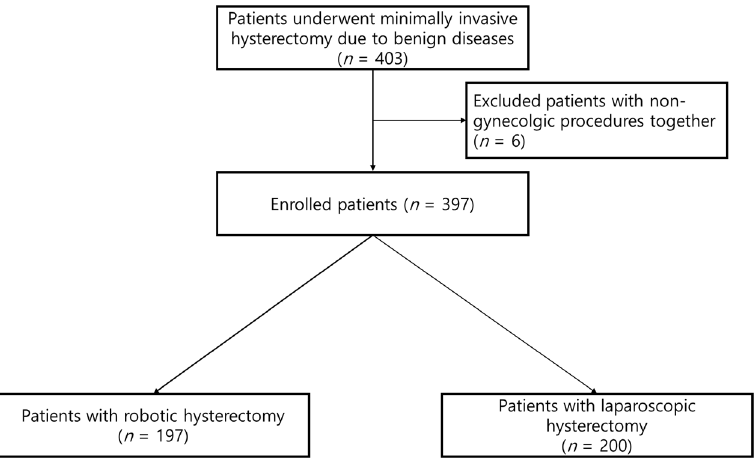
Figure 1. Flowchart for the enrolled patients.